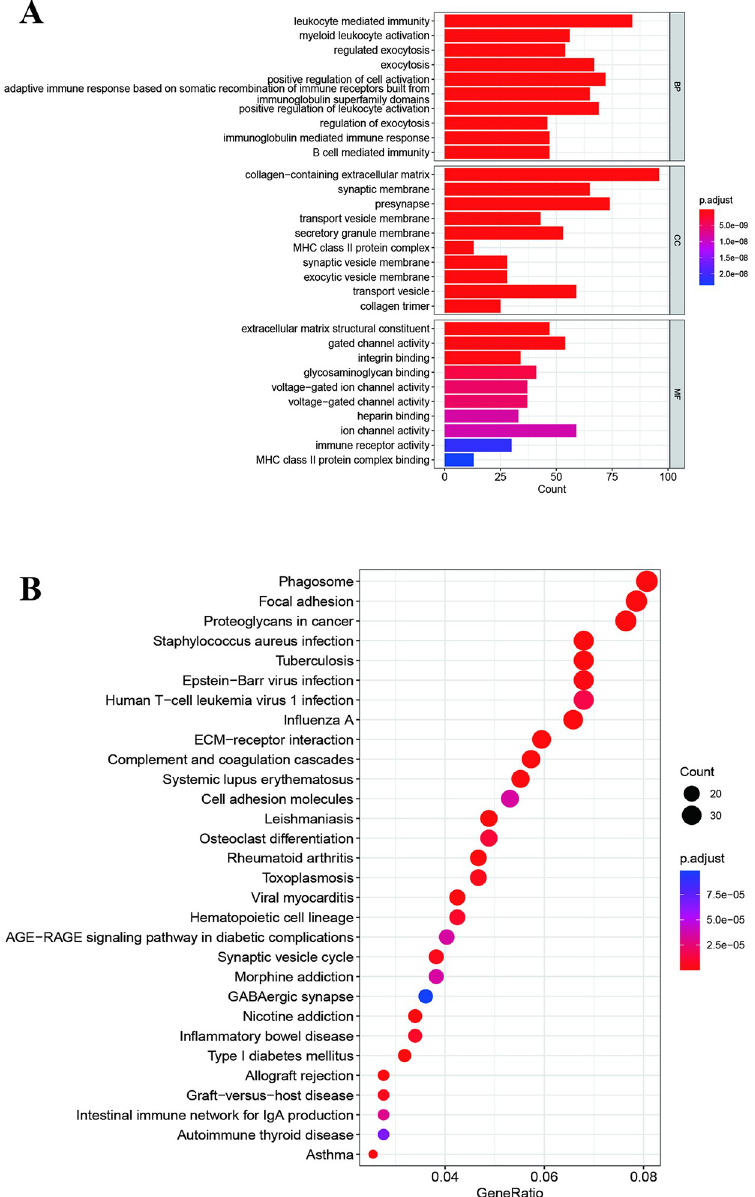
Fig 6. Function and pathways analysis based on DGEs between high- and low-risk groups. A: GO enrichment analysis. B: KEGG pathways analysis.